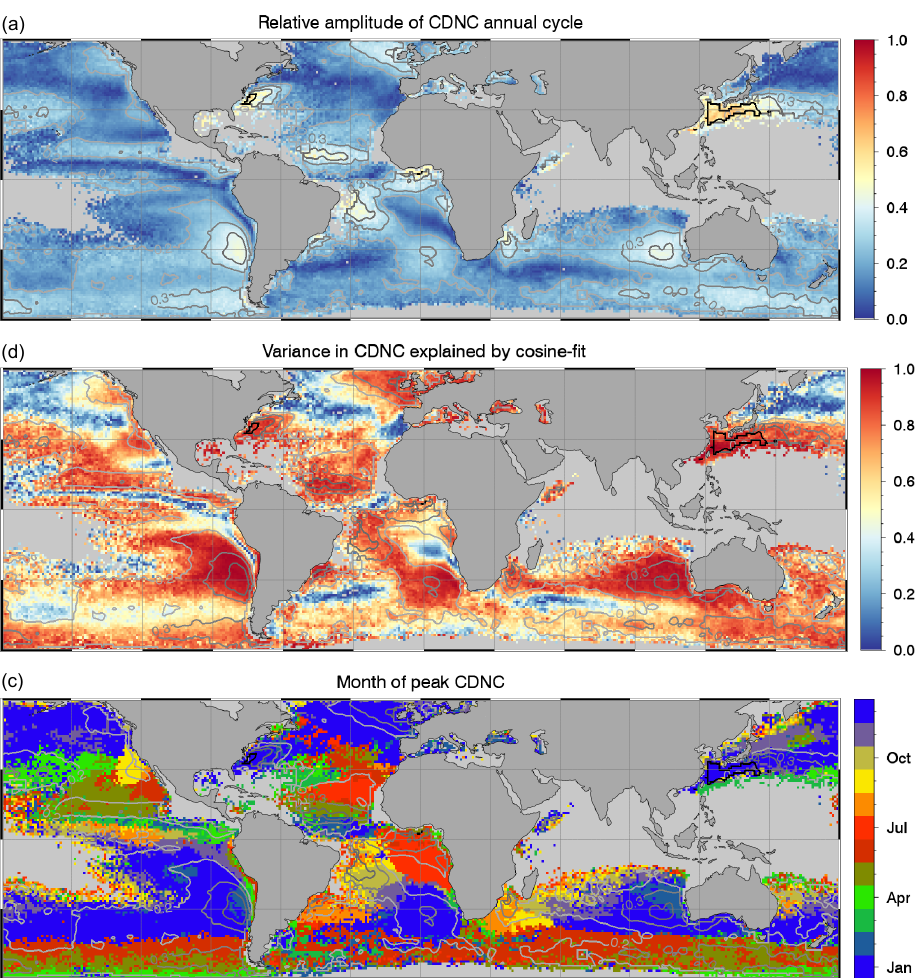
Figure 10. Panel (a) shows the relative magnitude of the 13-year mean annual cycle of CDNC. Panel (b) shows the variance explained by a simple cosine fit of the 13-year mean annual cycle. Panel (c) shows the months of the occurrence of the maximum CDNC. The isolines in all three plots show the relative magnitude of the CDNC annual cycle (same as panel (a)